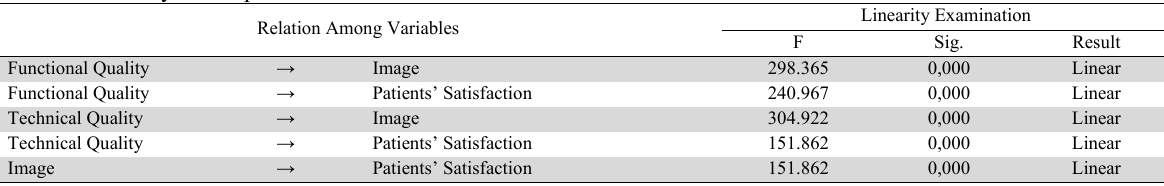
Result of Linearity Assumption Examination Relation Among